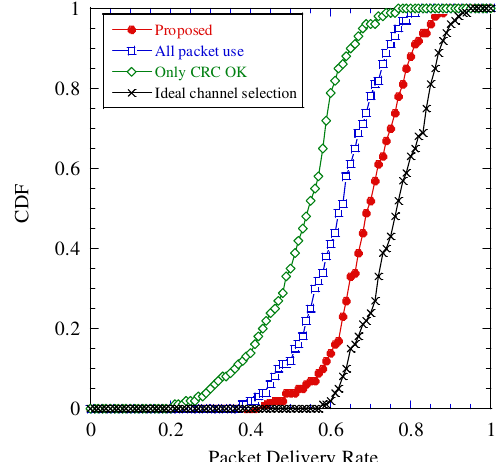
Figure 11. Cumulative distribution function (CDF) of the packet delivery